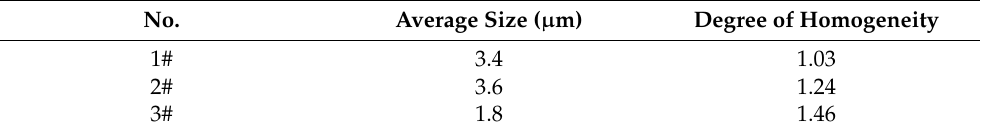
Table 4. Characteristic parameters of oxides for